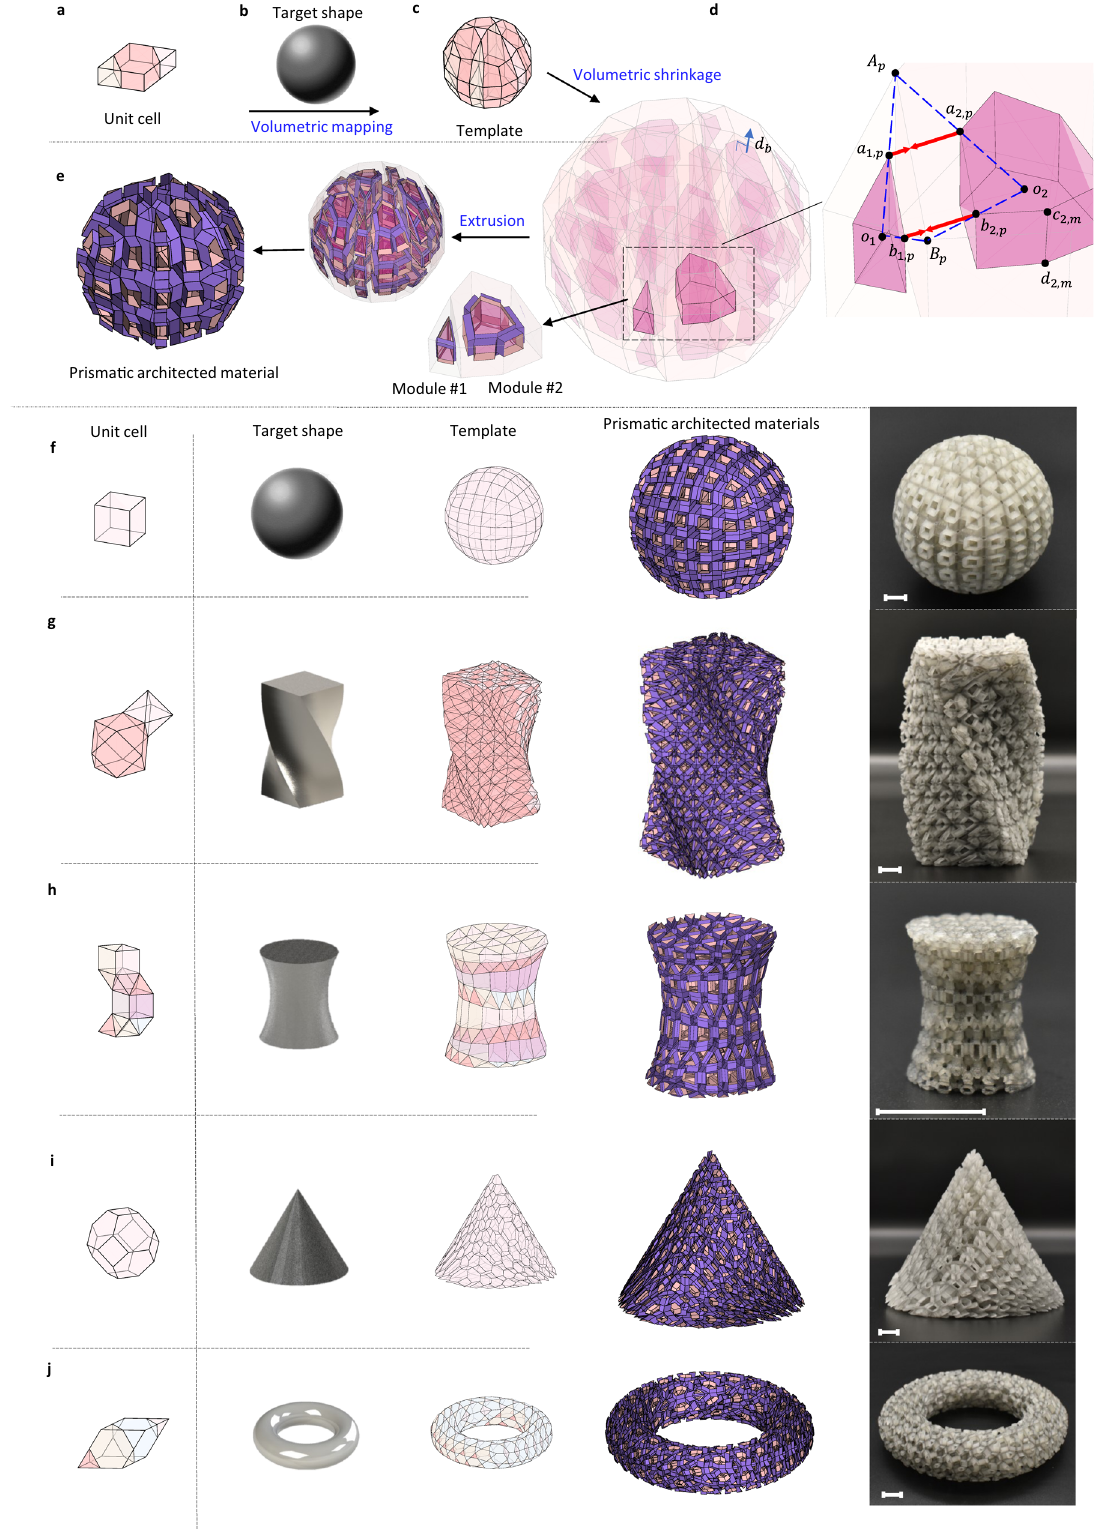
f – j Otherexamplesofthegeometricreconstructionforsynthesizing3Darchitected materials with modular origami. The rightmost column shows the 3D-printed prototypes (see Supplementary Note 4 of the SI for fabrication details). Scale bar,